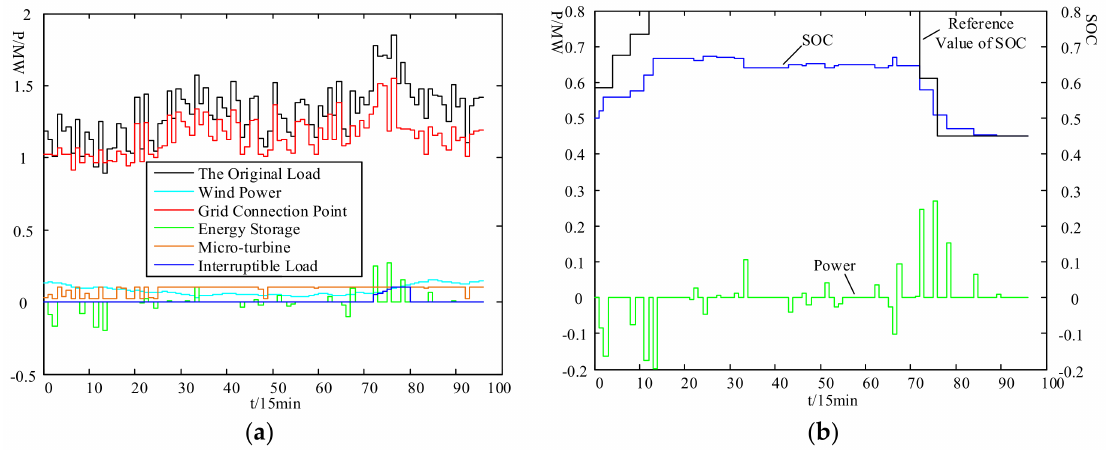
Figure 8. Results of intra-day optimal dispatch: ( a ) Power curve of each device; ( b ) State of energy